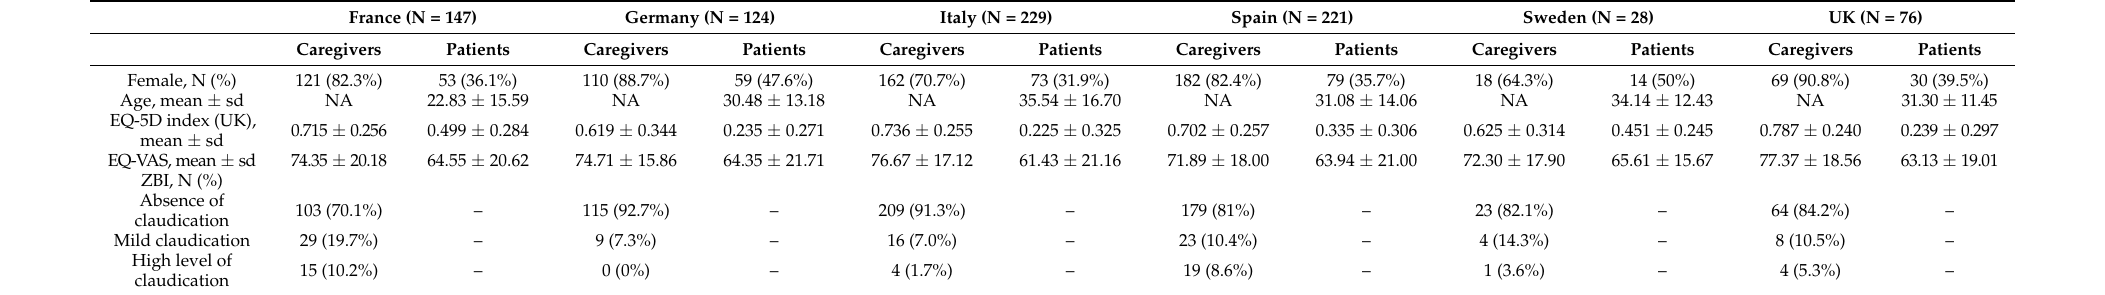
Table 1. Characteristics of caregivers and patients by